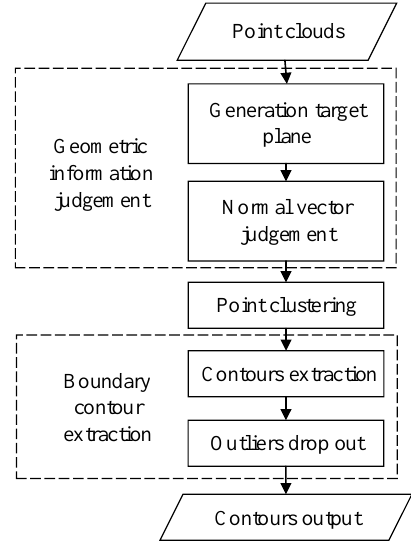
Figure 1. Flowchart of the proposed